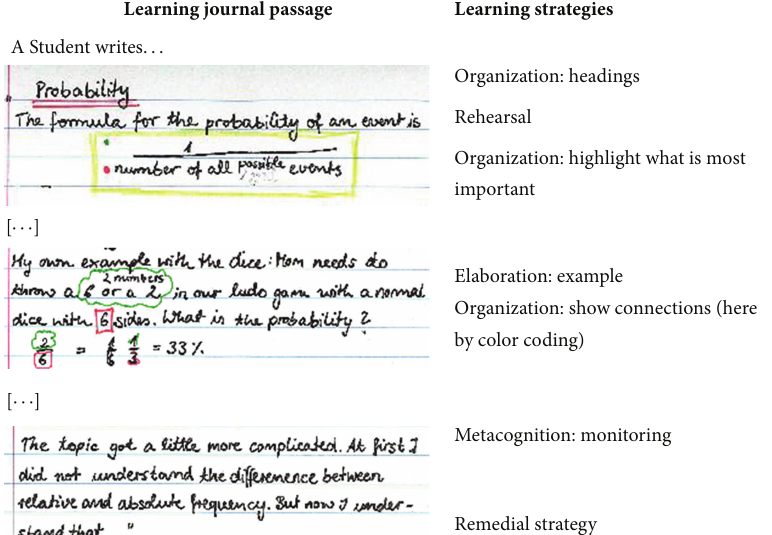
Figure 1: Examples of learning strategies in a ninth-grader’s mathematics learning journal. Glogger et al. [9] APA, reprinted with